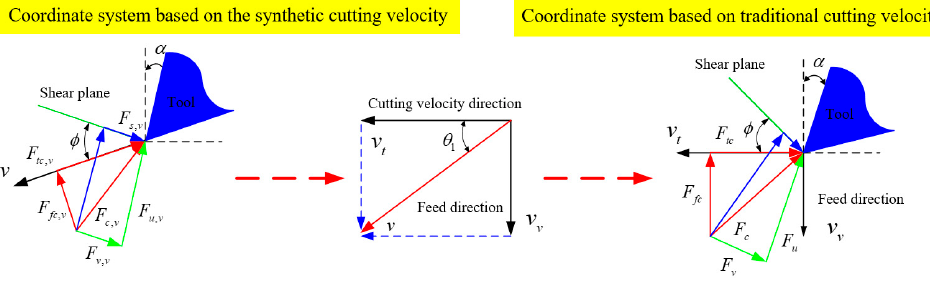
Materials 2022 , 15 , x FOR PEER REVIEW Figure 4. The coordinate relationship between synthetic cutting speed and traditional cutting speed.